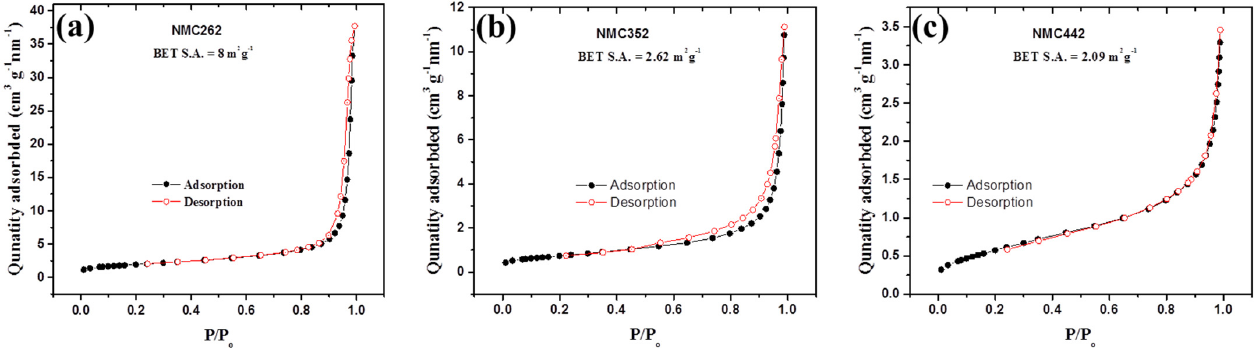
Figure 3. Nitrogen adsorption–desorption isotherm for ( a ) NMC262 ( b ) NMC352 and ( c ) NMC442.